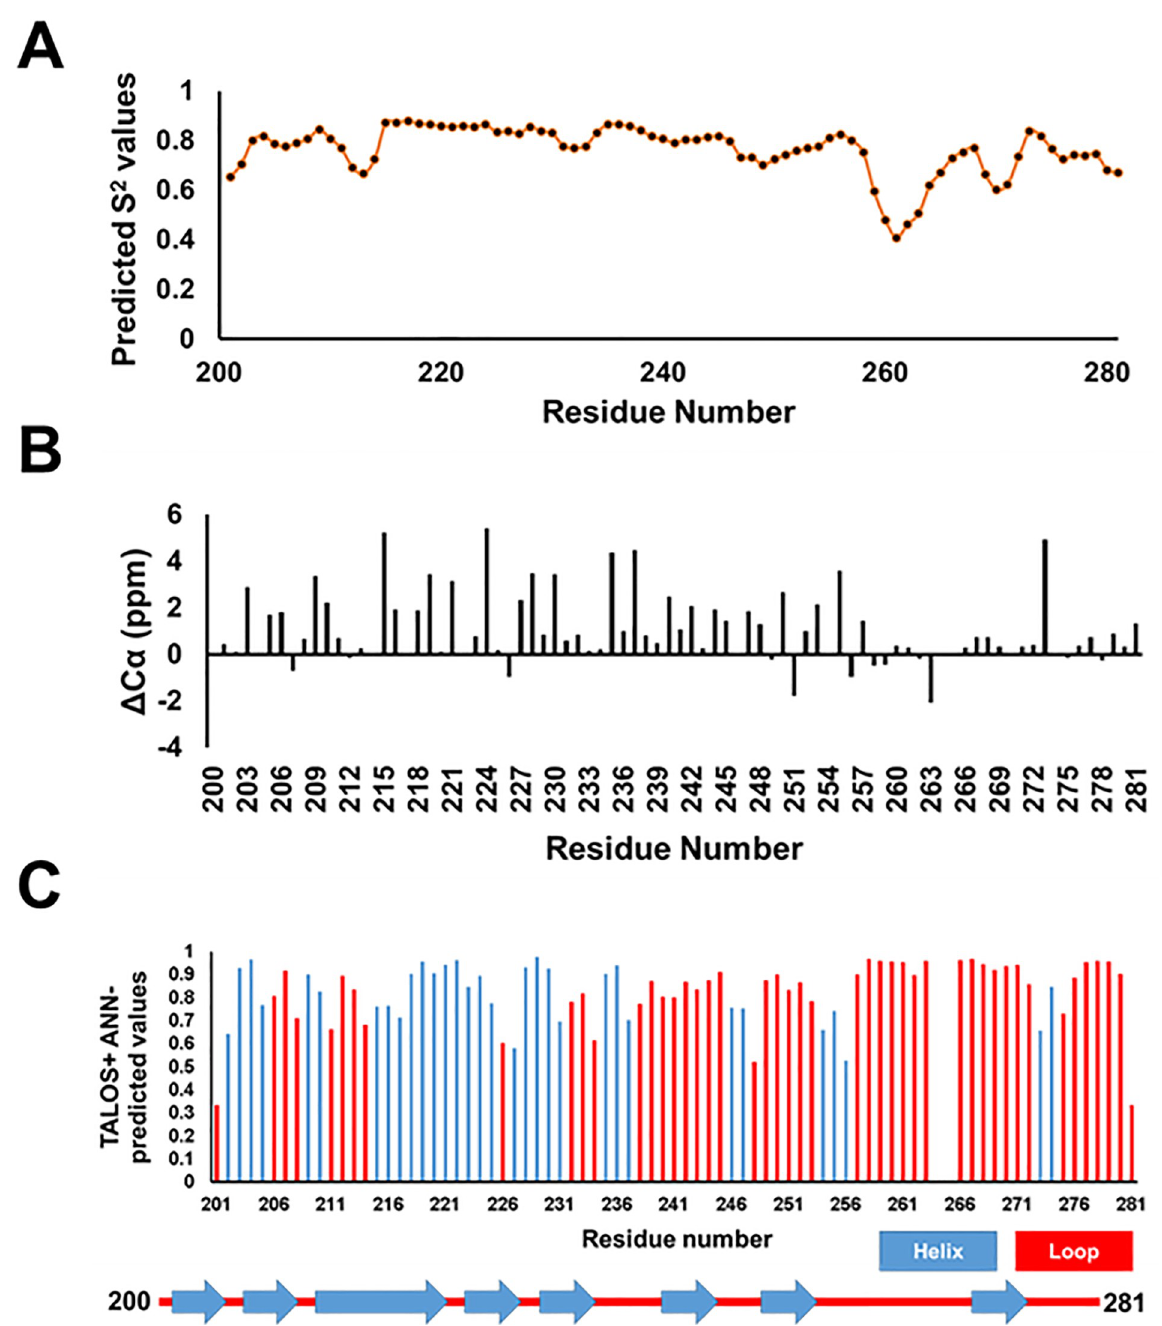
Fig 2. Secondary structure predictions for EB3 (200–281). A ) Predicted S 2 values for the backbone amide groups by the random coil index (RCI) approach indicates varying levels of backbone flexibility. B ) Deviation from random coil values for C α chemical shifts indicates the presence of helical elements. C ) Automated neural network (ANN)-predicted values for the helical region (blue) and loops (red) of the C- terminal domain of EB3. Predicted secondary structure elements are shown using blue arrows for α helices and red lines for coils. RCI S 2 and ANN-predicted values were calculated using the TALOS+ web server based on experimental NMR chemical shifts.